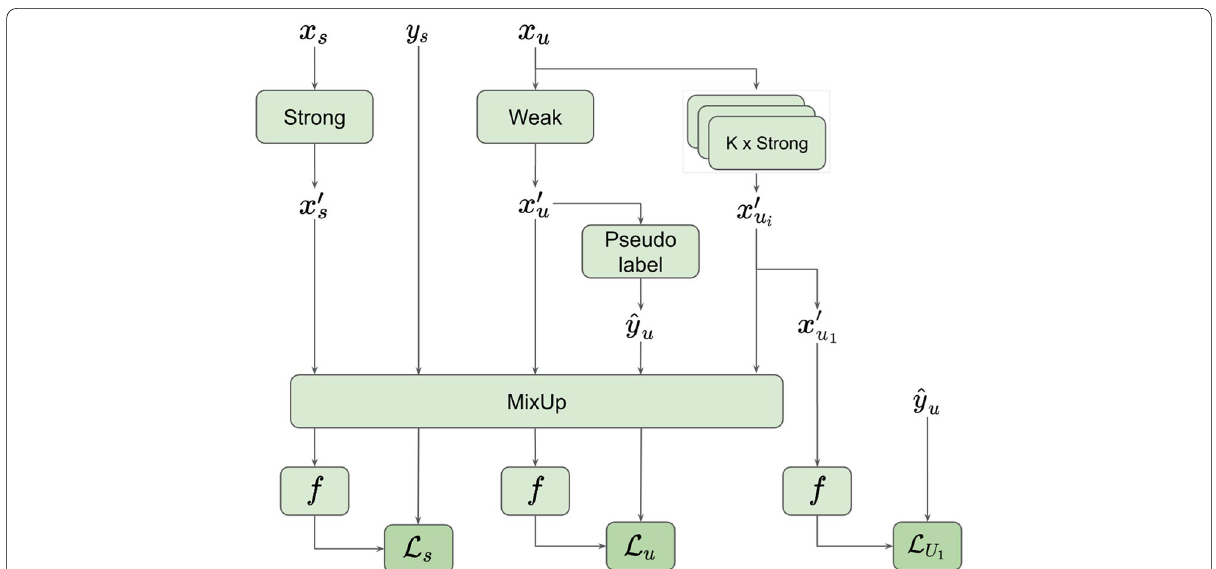
Fig. 4 RMM workflow. One weak and K strong augmentations are applied to the unlabeled data x u . The weakly augmented unlabeled data x ′ u are used to create pseudo labels ˆ y u . The first batch of strongly augmented unlabeled data x ′ u (using the pseudo-labels ˆ y u )